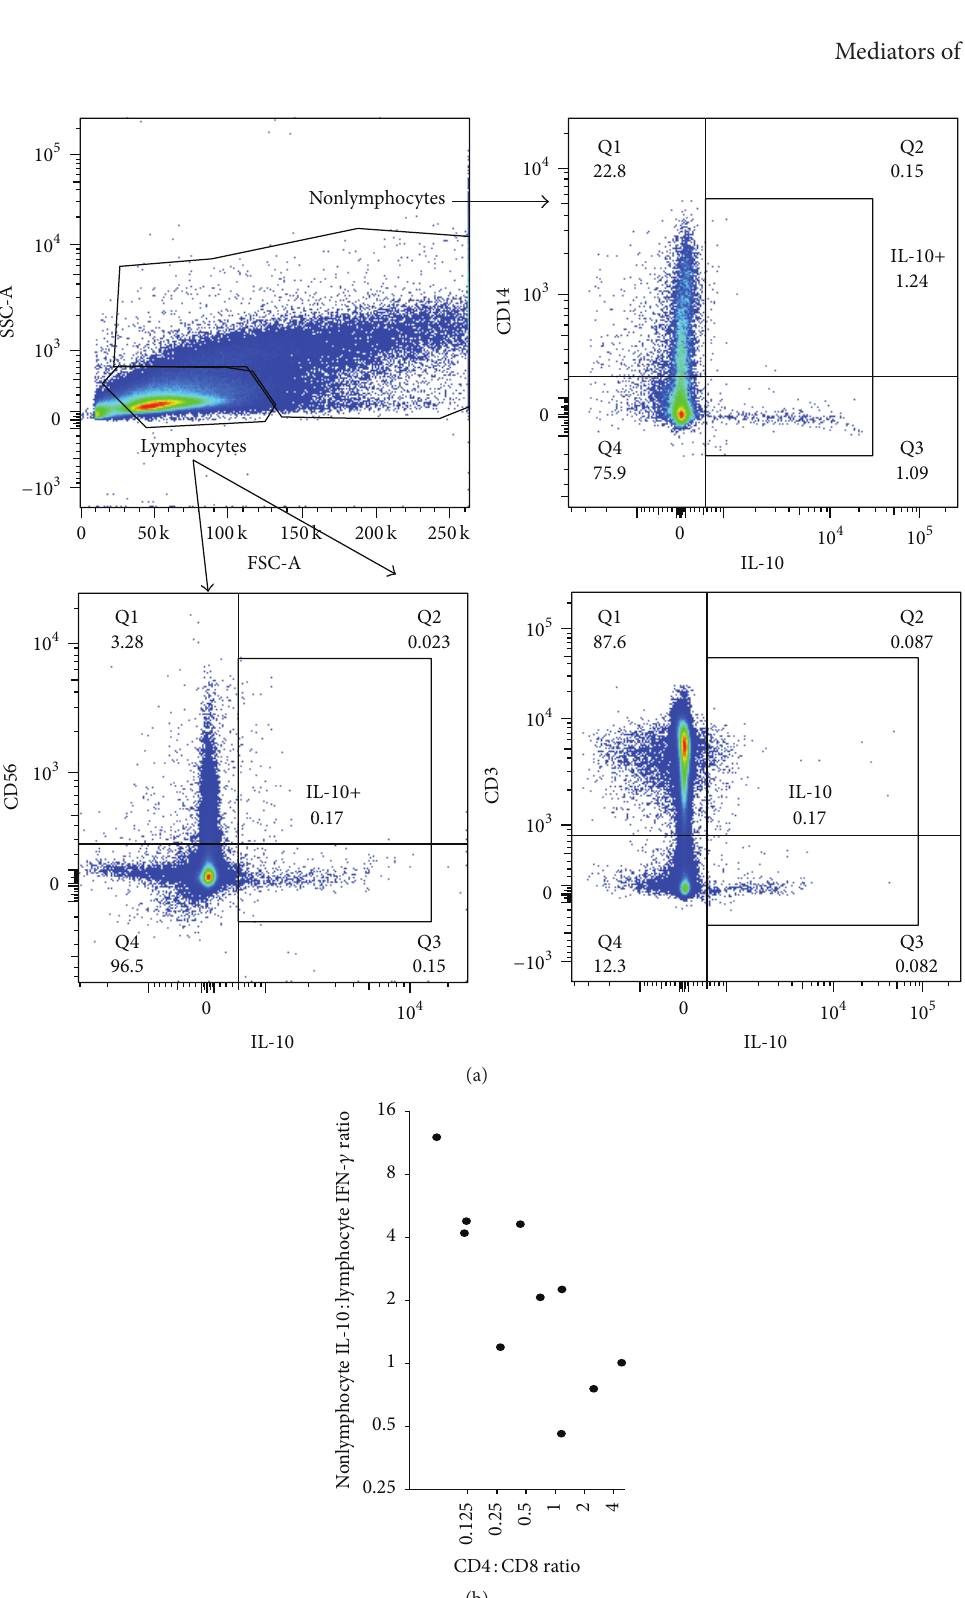
Figure 2: HIV progression increases the immune skewing towards nonlymphocyte IL-10 and away from lymphocyte IFN- 𝛾 . PBMCs from HIV-TB coinfected patients were stimulated with Mycobacterium bovis (M. bovis ) lysate to evaluate the etiology of IL-10 production. (a) Representative dot plots showing the relative contribution of cell types towards IL-10 production. Side scatter (SSA-A) and forward scatter (FSA-A), CD3, CD56, and CD14 were used to evaluate the lymphocyte or nonlymphocyte contribution of IL-10 production. (b) Spearman correlation of the mycobacteria-specific nonlymphocyte IL-10: total lymphocyte IFN- 𝛾 production based on the CD4 :CD8